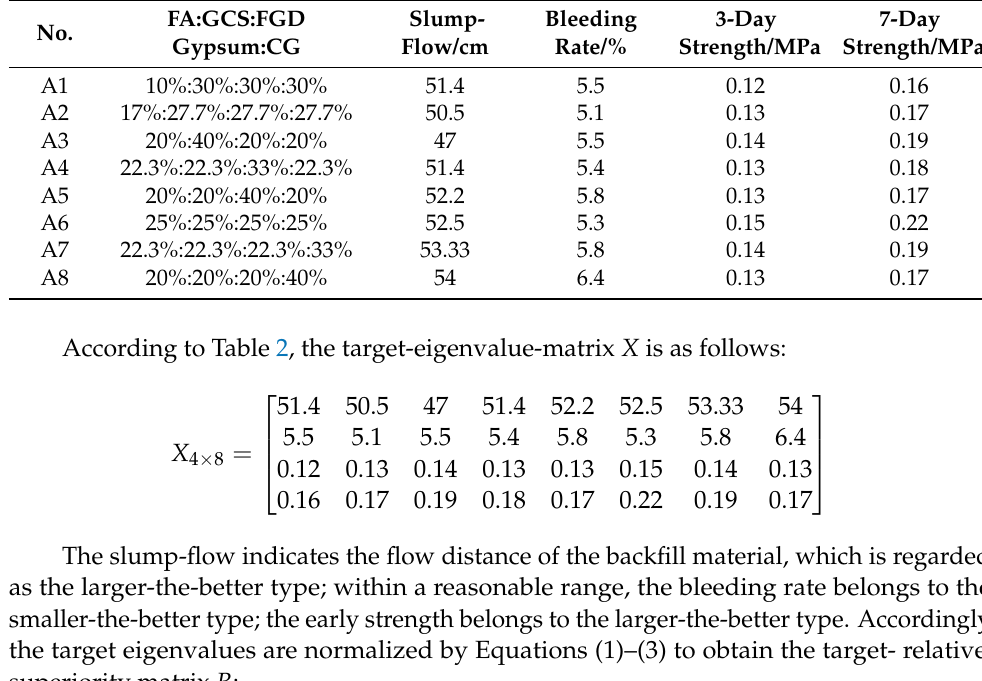
Table 2. Target-characteristic values of solid-waste-proportioning